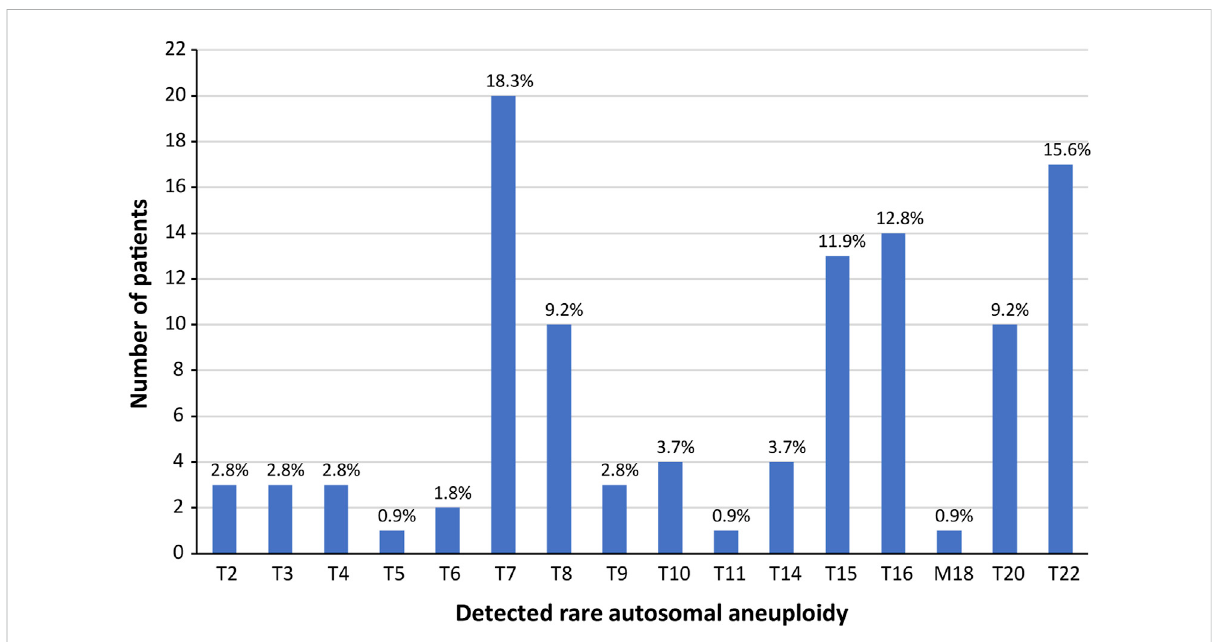
FIGURE 1 Detected rare autosomal aneuploidies in the study cohort. There were no rare autosomal aneuploidies observed on chromosomes 1, 12, 17, or 19; trisomies observed on chromosomes 13, 18, or 21 were not